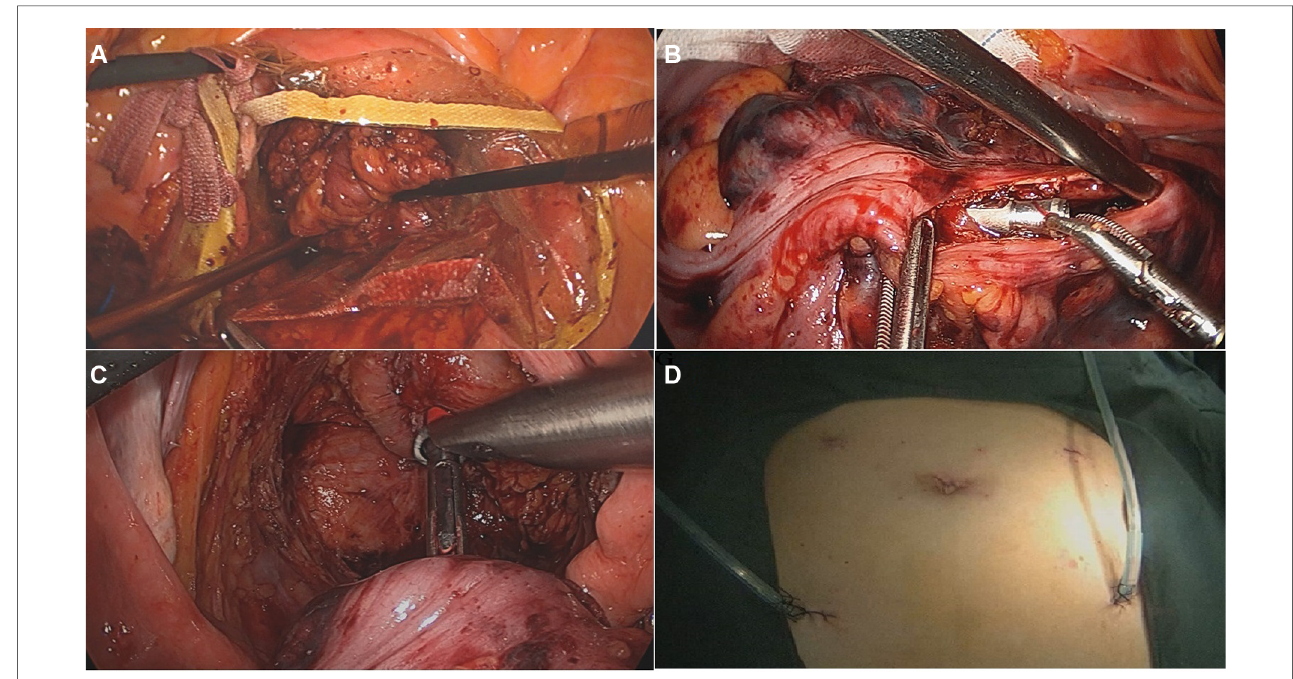
FIGURE 2 The surgical procedure of NOSES. ( A ) The specimen was pulled out through the disposable sterile protective cover; ( B ) the anvil head was inserted into the colon lumen through the incision; ( C ) end-to-end colorectal anastomosis was performed with the use of a circular stapling device; ( D ) no auxiliary incision in the abdomen after